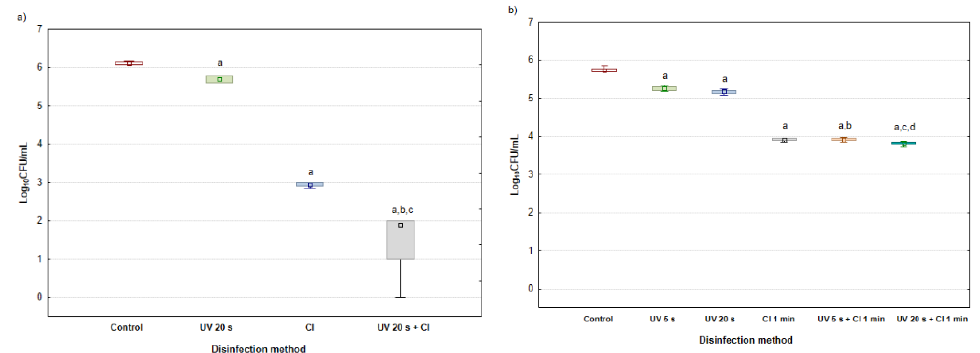
Figure 3. Total bacterial count expressed as log 10 CFU/mL after the treatment of ( a ) the planktonic form of Pseudomonas aeruginosa , before biofilm formation and after the treatment of ( b ) the 5-day- old biofilm of Pseudomonas aeruginosa. The results are presented as median with minimum and maximum values (N = 9), performed in triplicate and repeated three times for each experiment. Median values marked with a lowercase letter a represent significant differences between control group and disinfection methods, whereas lowercase letters b, c, and d represent significant differences between disinfection methods ( p < 0.05; nonparametric Mann-Whitney U test).